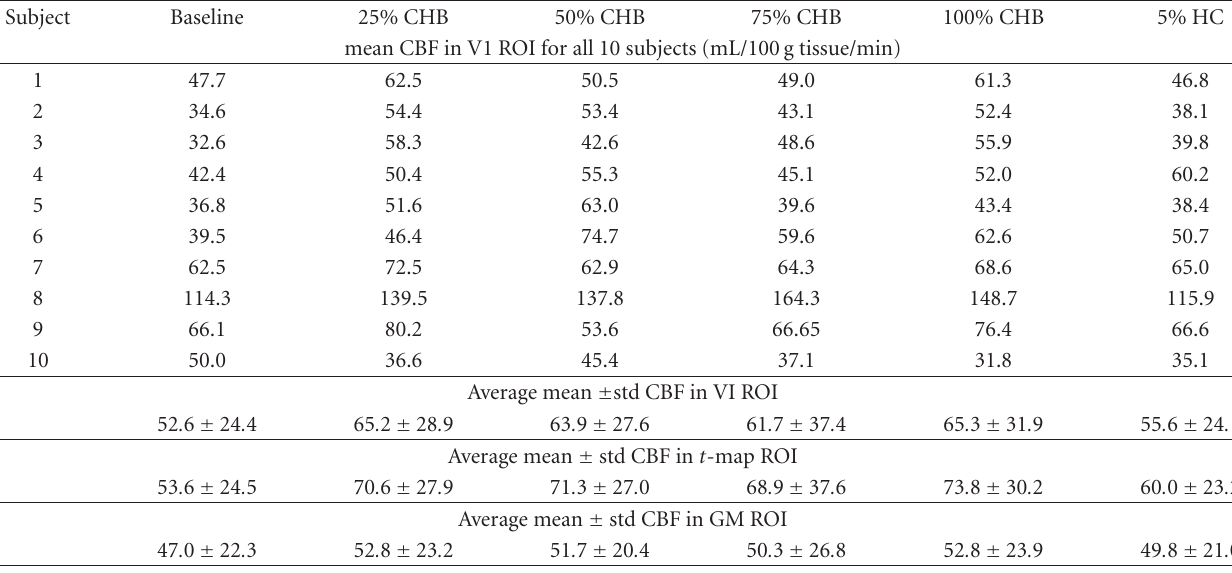
Table 1: CBF measured with PET in 10 subjects under 6 experimental conditions (baseline, 4 levels of graded visual checkerboard (CHB) stimulation as well as hypercapnia (HC)) in the V1 ROI, followed by the CBF measurements averaged over the 10 subjects in all 3 ROIs— V1, t -map, and GM ROIs. The PET Δ CBF measurements have a high standard deviation, largely attributable to the abnormally high CBF measured in subject 8.